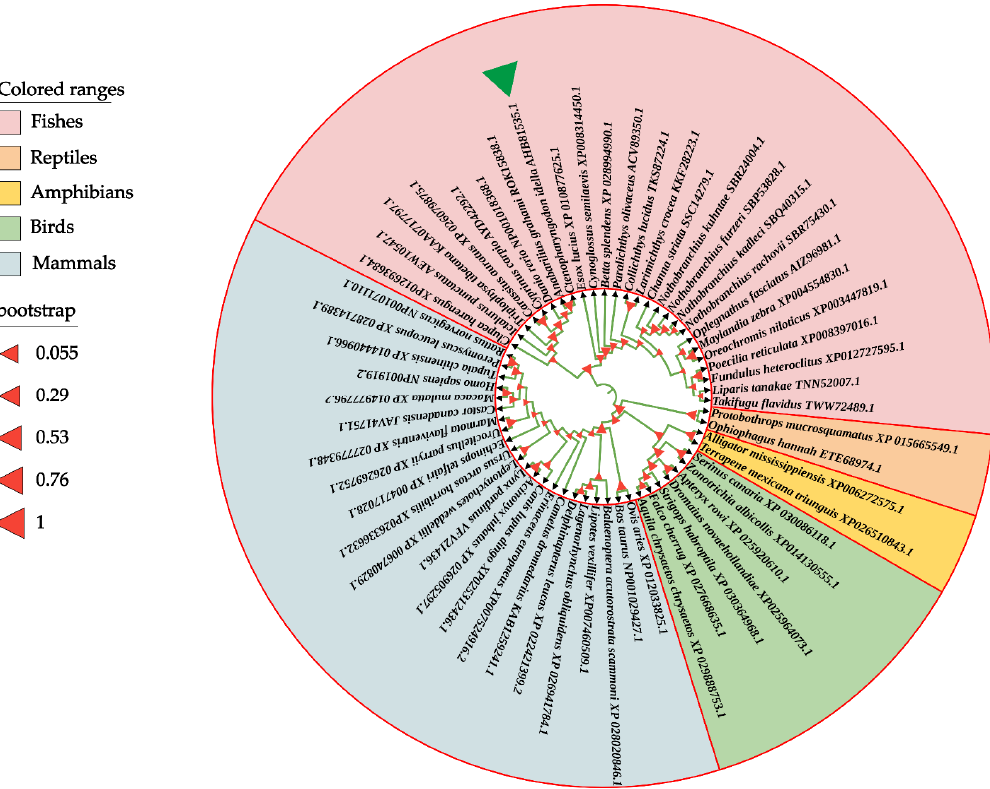
Figure 5. Phylogenetic relationship of Df proteins from various vertebrates. The phylogenetic tree is constructed using the neighbor-joining method and MEGA 6.06 software based on full-length Df protein sequences from different species. The Ci Df protein is indicated by a green solid triangle. All of the selected Df proteins are separated into five branches that are marked by different colors.